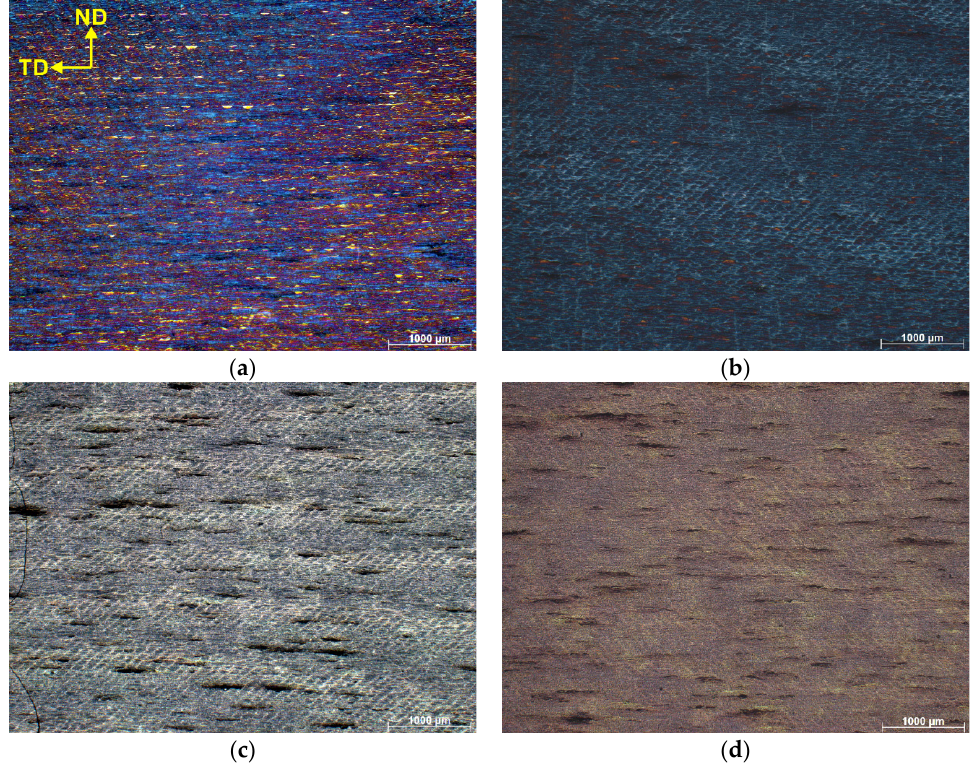
Figure 5. Microstructures of ECAP-processed samples ( a ) HT280E150; ( b ) SLME350; ( c ) SLME400; ( d ) SLME450.